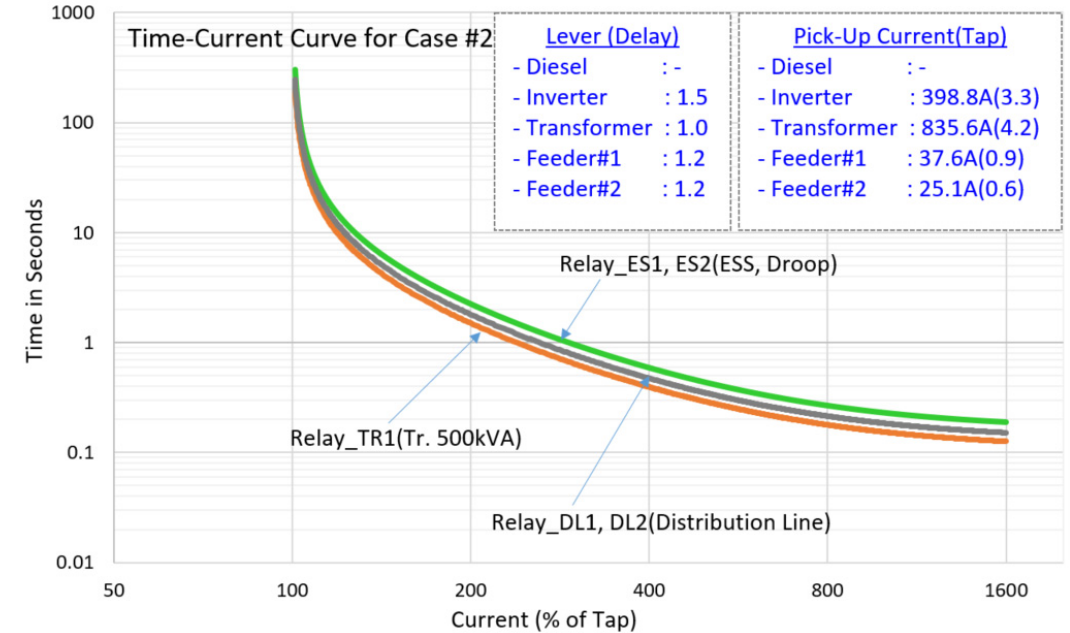
Figure 9. T-C curve for case #2 (ESS only).